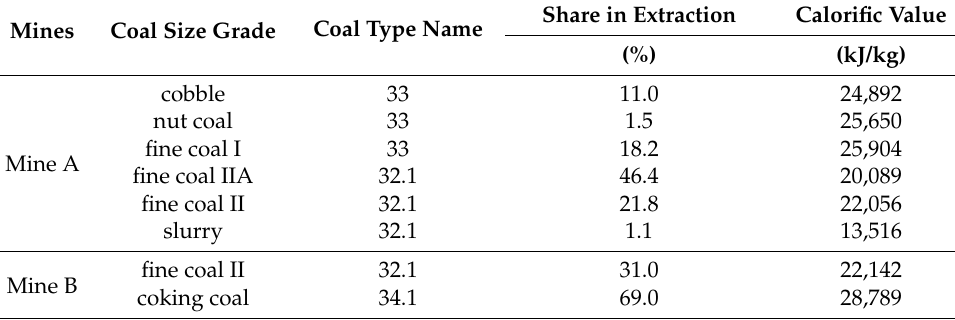
Table 2. Types and quality parameters of coal offered by